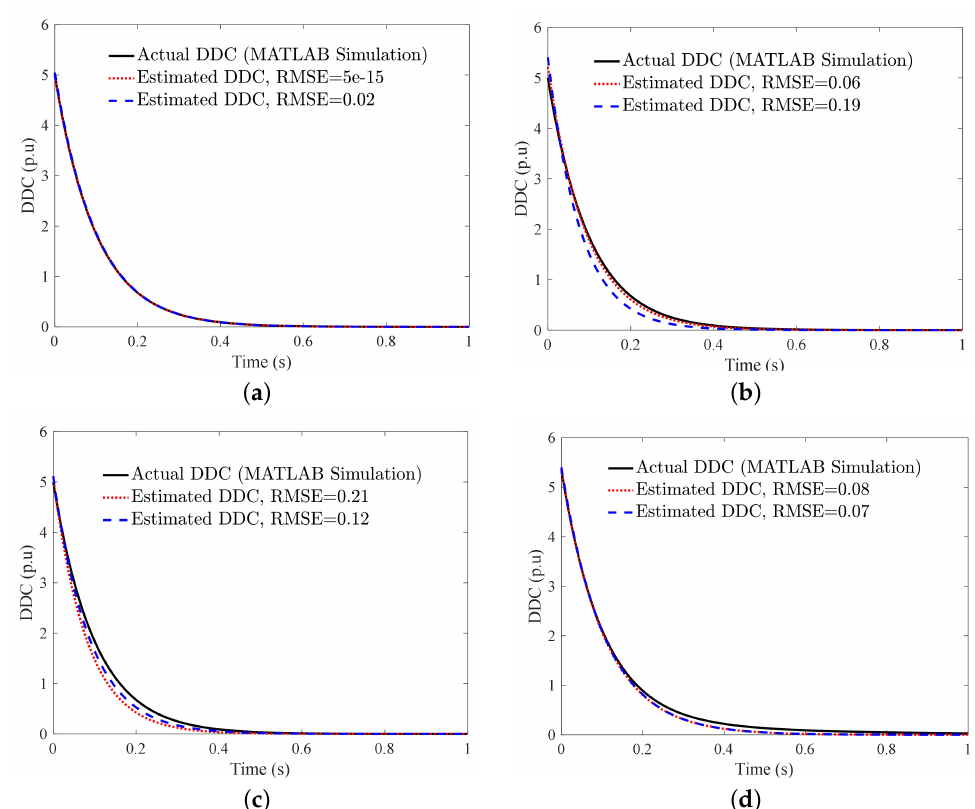
Figure 9. simulation results, methods [10] (red line) and [11] (blue line), under four different cases: ( a ) without noise, ( b ) in the presence of noise, ( c ) 0.5 Hz frequency deviation, ( d ) in the presence of the second